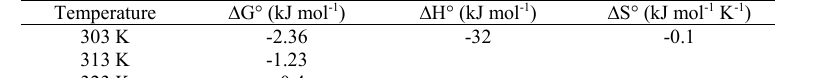
Table 3: Thermodynamics parameters for the adsorption of methylene blue onto sawdust at different temperatures. The negative values of ∆G° indicate the spontaneous adsorption of MB onto sawdust samples. Temperature